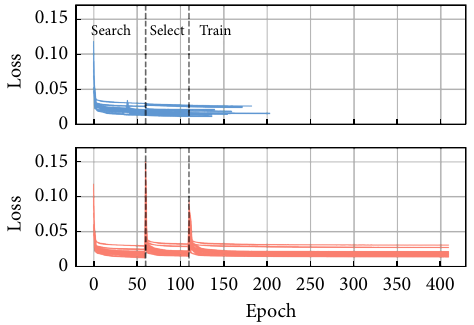
Fig. 13 Three-staged fitting process over all datasets. (up: MDARTS, down: ODARTS)